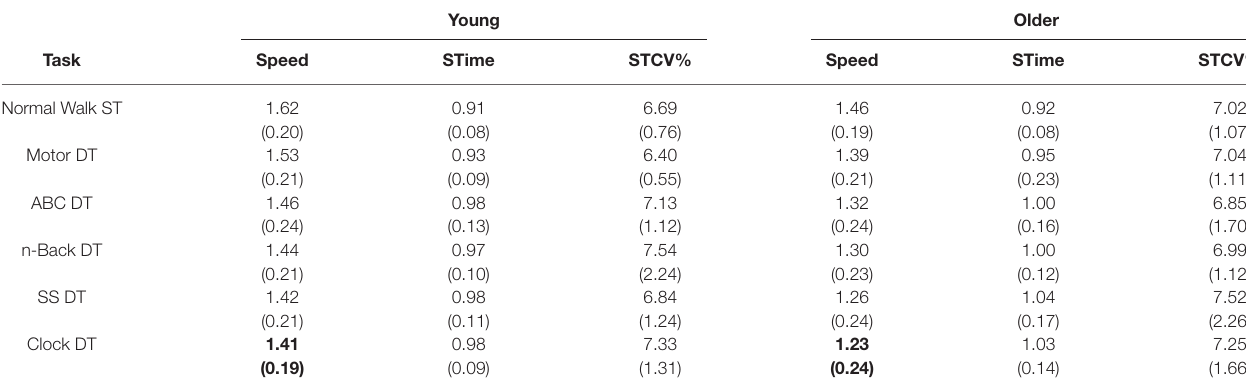
TABLE 1 | Mean (SD) of speed, stride time (STime) and stride time variability (STCV) on all task for young and older groups . Young Older Task Speed Normal Walk ST